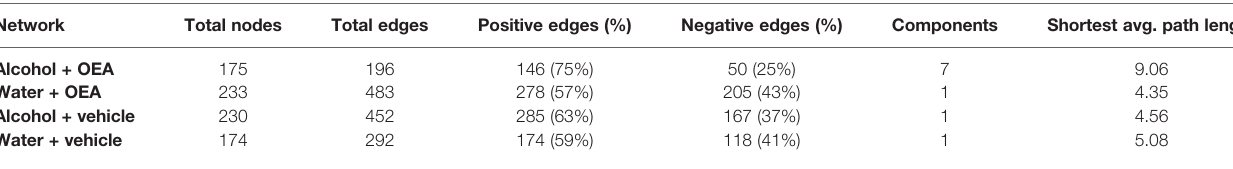
TABLE 1 | Properties of the networks reported in Figure 4 . Network